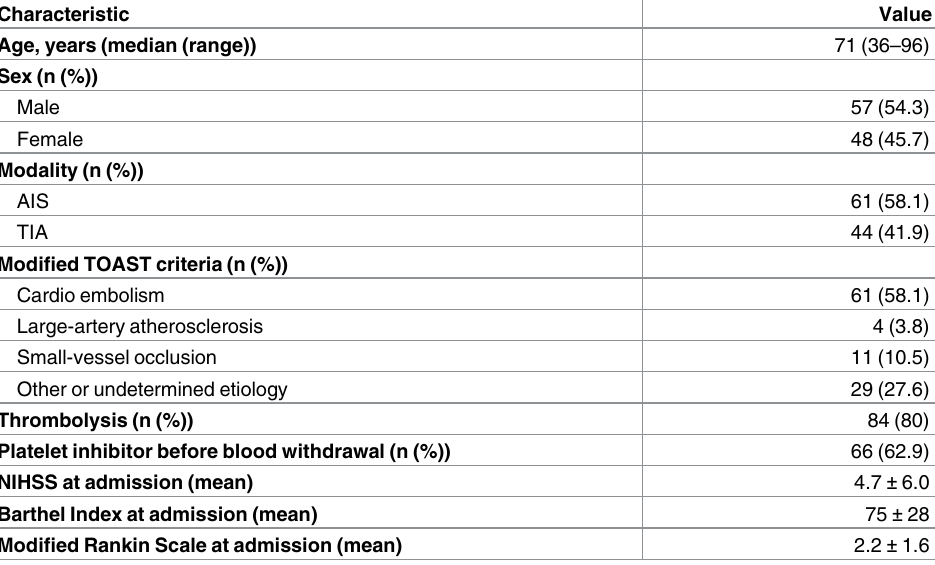
Table 1. Baseline characteristics of the acute stroke patients (acute ischemic stroke (AIS) and tran- sient ischemic attack (TIA)). Data are represented as mean ± standarddeviation(SD). (NIHSS: National Institutes of Health stroke scale; TOAST: Trial of Org 10172 in Acute Stroke